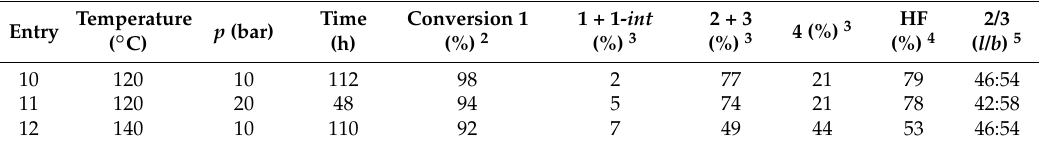
Table 3. Tandem isomerization–hydroformylation of oleonitrile by the Rh(acac)(CO) 2 –Biphephos system at a CO/H 2 ratio = 4.